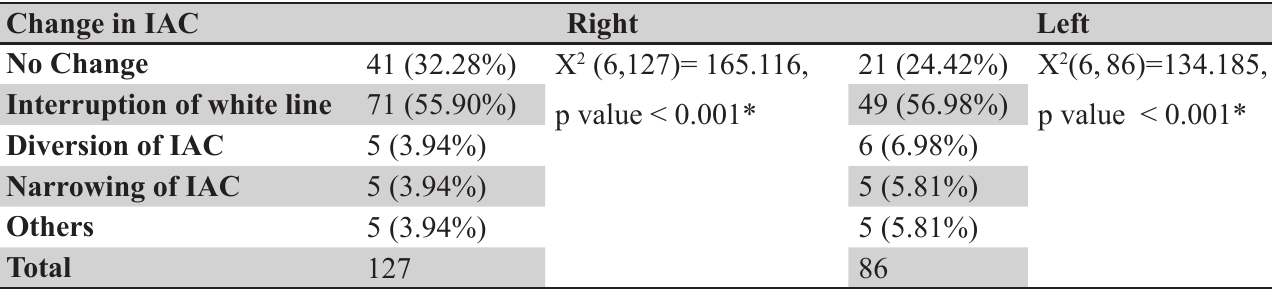
Table 2a. Darkening of roots of mandibular third molar on right and left side of mandible with respect to change in IAC seen on the same side.